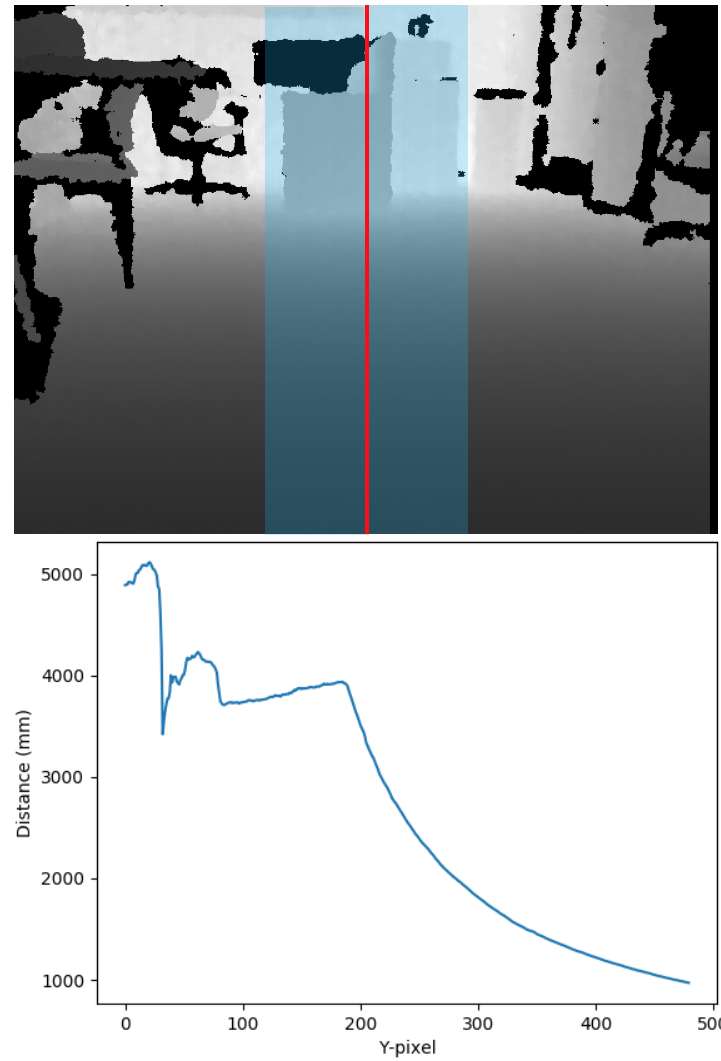
Figure 3. Top: The depth component of an image recorded by a Kinect camera in configuration (C). Darker colors show closer points, with black pixels representing points for which depth information is not available. The blue central column is the area processed for obstacle detection. Bottom: The one-dimensional array extracted from the depth map. Pixel 500 refers to the bottom of the